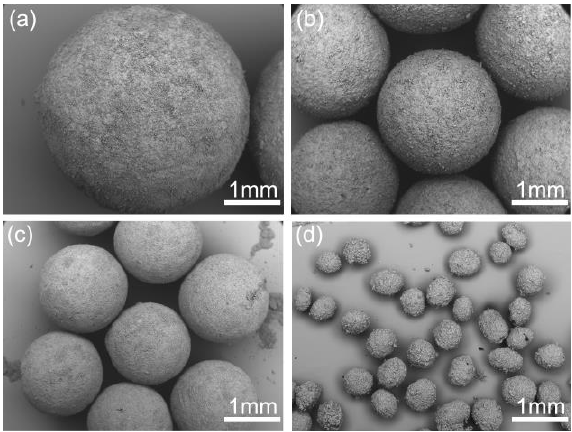
Figure 8. SEM images of the spherical crystals prepared at different stirring speeds: ( a ) 300 rpm, SA-1; ( b ) 500 rpm, SA-2; ( c ) 700 rpm, SA-3; ( d ) 1000 rpm, SA-4.